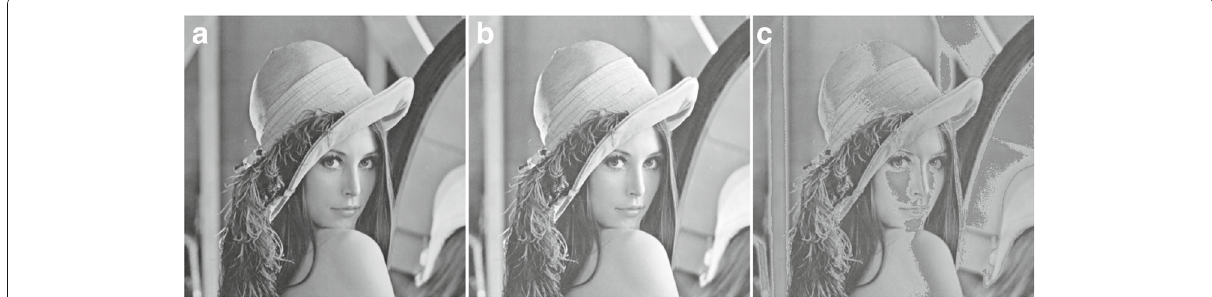
Fig. 2 The MSE effect on brightness increase: a Original Lena image. b Lena image after adding a constant value of 30 to all pixel values to increase the brightness. c Lena image after subtracting a constant value of 30 from any pixel value less than 150 and adding a constant value of 30 otherwise; the MSE between the images in a and b is equal to 900, while the MSE between the images in a and c is also